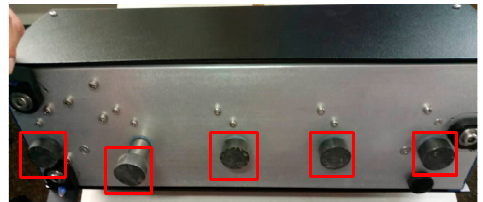
Figure 7. Image of the standard five-hammer vibration device.